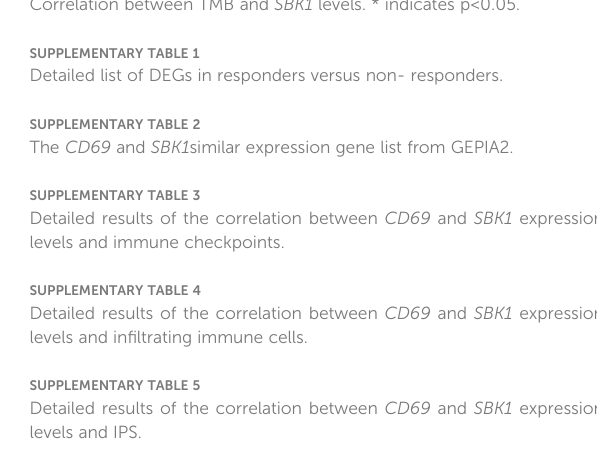
SUPPLEMENTARY FIGURE 1 Analysis of the correlation between CD69 and SBK1 expression levels and immune checkpoints in all TCGA tumors. (A) Correlation between immune checkpoints and the expression levels of CD69 . (B) Correlation between immune checkpoints and the expression levels of SBK1 . * indicates p<0.05. SUPPLEMENTARY FIGURE 2 Analysis of correlation between the levels of CD69 and SBK1 , and in fi ltrating immune cells in all TCGA tumors. (A) CD69 positively correlates with various immune cells in most TCGA tumors. Top left corner: p-value. Lower right corner: correlation coef fi cient. (B) SBK1 negatively correlates with various immune cells in most TCGA tumors. * indicates (p<0.05). SUPPLEMENTARY FIGURE 3 Analysis of correlation between the levels of CD69 and SBK1 , and TMB in all TCGA tumors. (A) Correlation between TMB and CD69 levels. (B) Correlation between TMB and SBK1 levels. * indicates p<0.05. SUPPLEMENTARY TABLE 1 Detailed list of DEGs in responders versus non- responders. SUPPLEMENTARY TABLE 2 The CD69 and SBK1 similar expression gene list from GEPIA2. SUPPLEMENTARY TABLE 3 Detailed results of the correlation between CD69 and SBK1 expression levels and immune checkpoints. SUPPLEMENTARY TABLE 4 Detailed results of the correlation between CD69 and SBK1 expression levels and in fi ltrating immune cells. SUPPLEMENTARY TABLE 5 Detailed results of the correlation between CD69 and SBK1 expression levels and